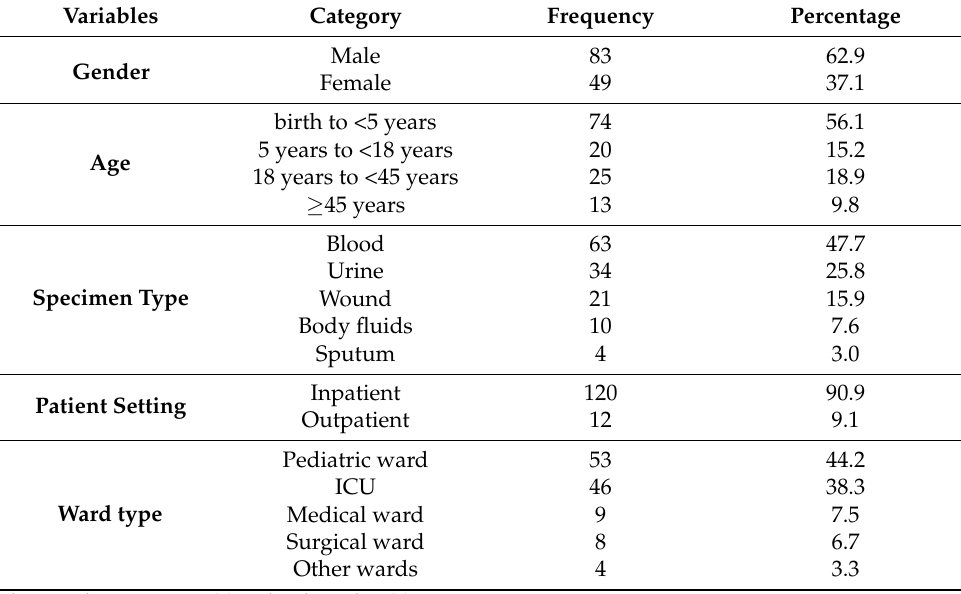
Table 1. Distribution of K. pneumoniae isolates among demographic and clinical characteristics of study